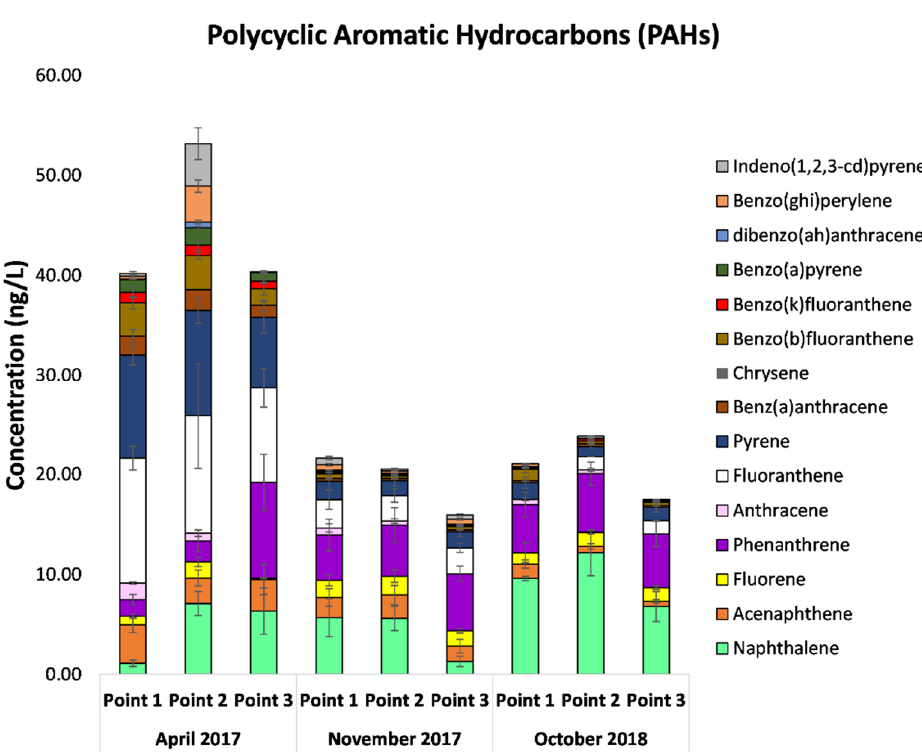
Figure 3. Concentration values (ng/L) for the fifteen PAHs measured at the three sampling points (1, 2 and 3) during the three sampling